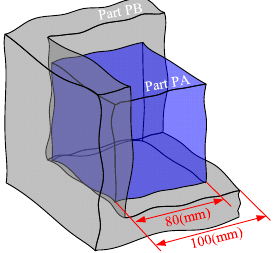
Figure 8. Assembly with three mating planes.